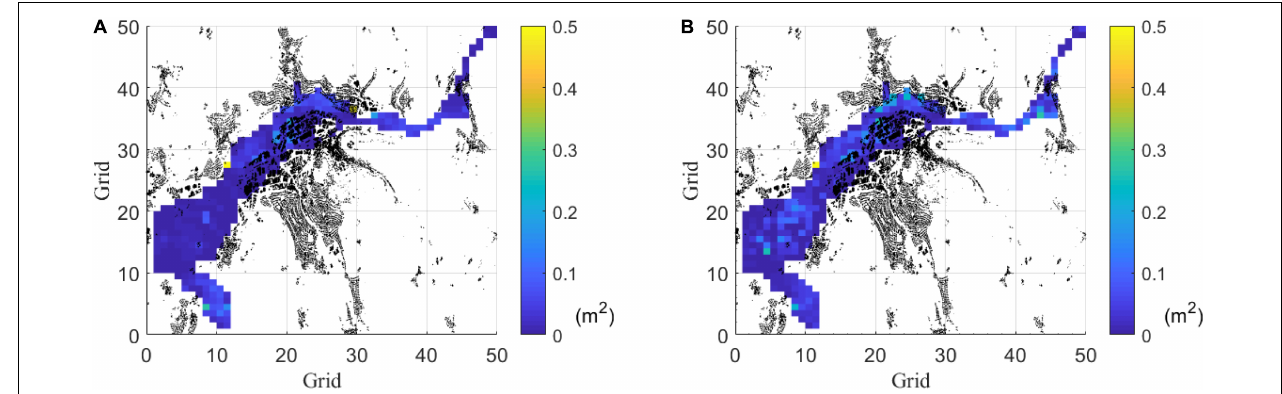
FIGURE 3 | Comparison of average MSE by the two training algorithms in the testing dataset (Event #121 to Event #180). Each grid is an ANN. Black elements are houses. (A) Average (among events) MSE by resilient backpropagation (RP). (B) Average (among events) MSE by conjugate gradient (CGF).